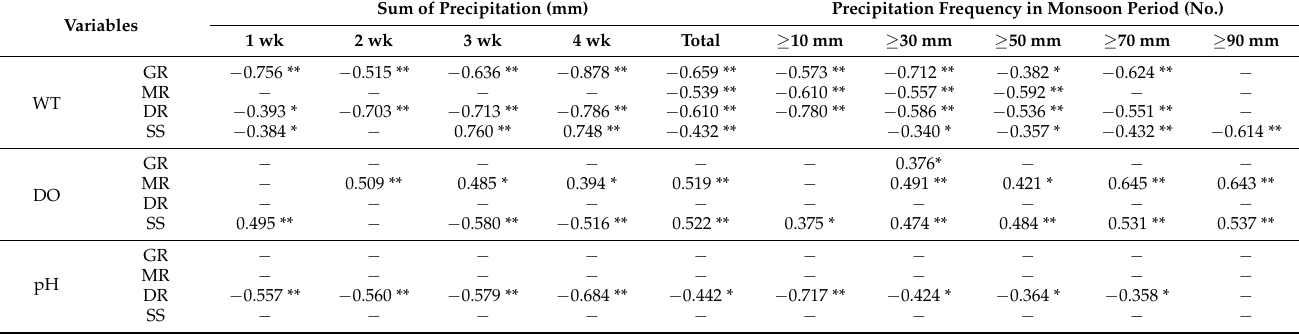
Table 4. Correlation coefficients between precipitation pattern and temporal variabilities of envi- ronmental factors in four central western major streams of the Korean Peninsula from 2013 to